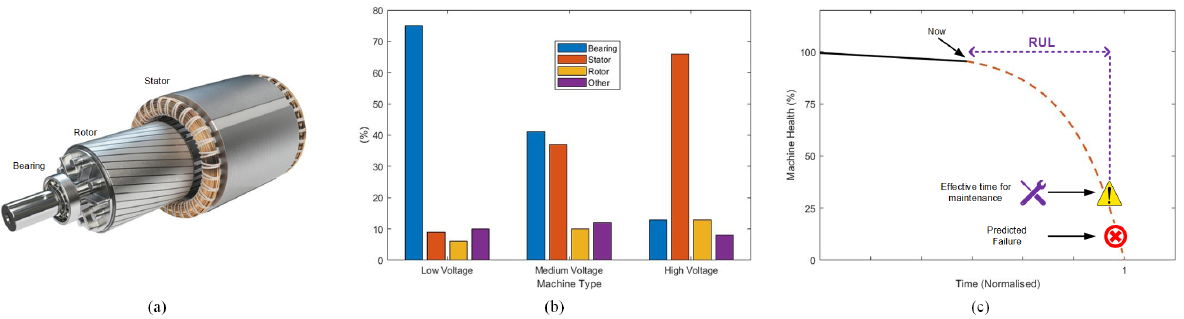
Figure 1. ( a ) The main components of an electric machine, ( b ) percentage occurrences of failure modes from the statistical data presented in [2,6] and ( c ) typical degradation trend and remaining useful life of an operating